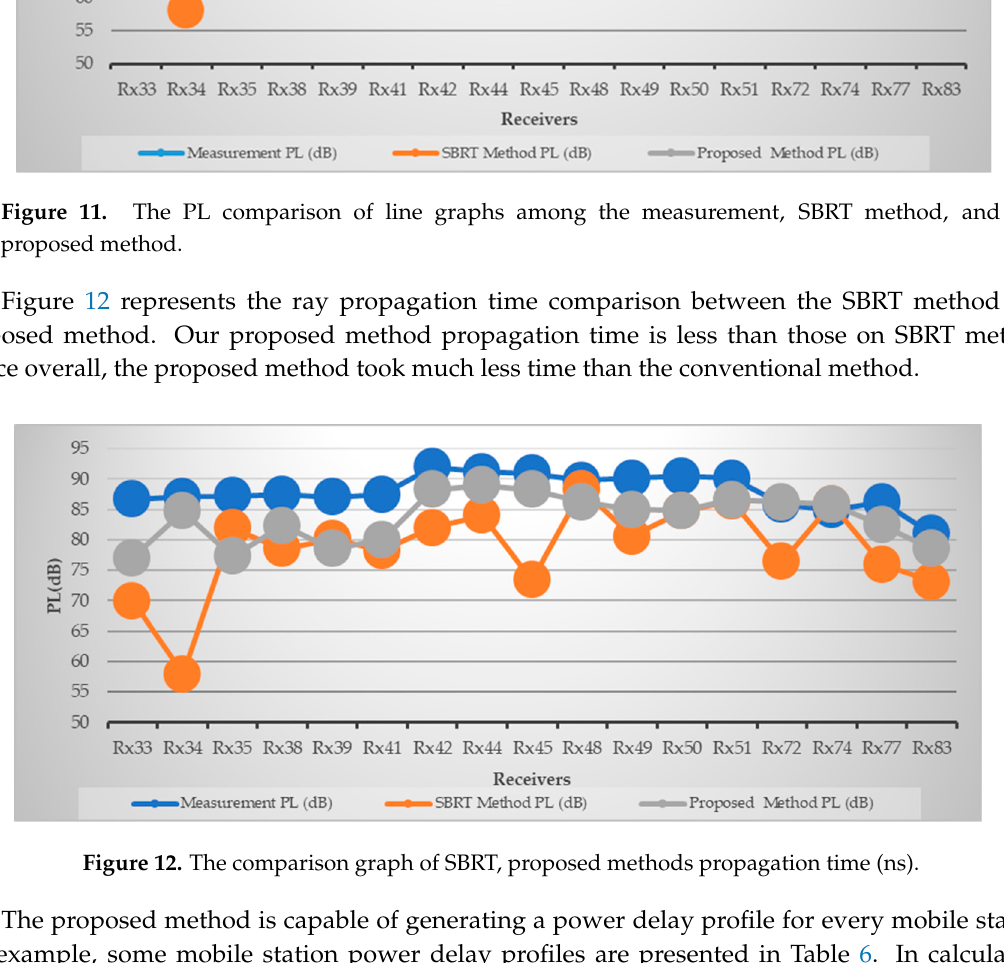
Figure 12. The comparison graph of SBRT, proposed methods propagation time (ns).